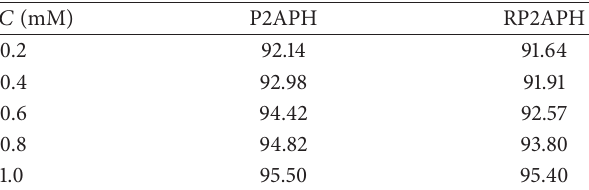
Table 1: Gravimetric corrosion inhibition efficiencies ( 𝜂 𝑤 %) of P2APH and RP2APH on CS in 1M HCl for 24 h at 29 ± 0.2 ∘ C.